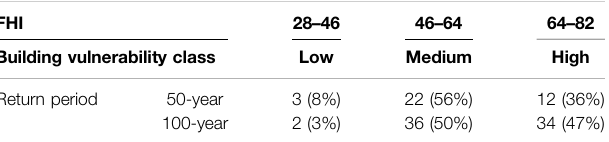
TABLE 12 | Number of buildings by building vulnerability